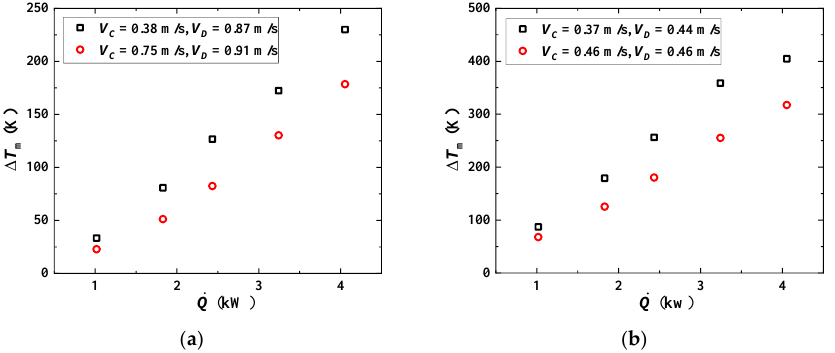
Figure 7. Variation in maximum temperature rise with HRR under similar velocities on ramp D: ( a ) φ = 10%; ( b ) φ = 20%. The velocities of ramp C and ramp D jointly affected the maximum temperature rise. Any change in the velocities of one of the ramps would cause the maximum temperature rise to vary. The influence of ramp D was greater, which could have been because the fire source was positioned on ramp D and influenced it significantly.